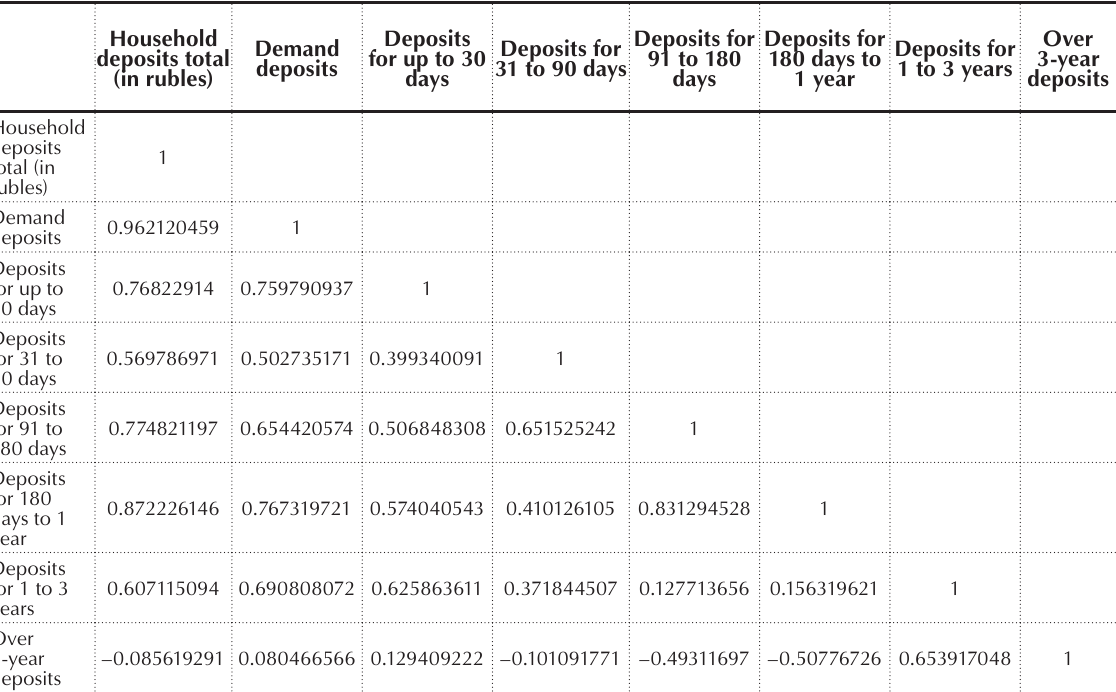
Table 9. (cid:18)(cid:381)(cid:396)(cid:396)(cid:286)(cid:367)(cid:258)(cid:415)(cid:381)(cid:374)(cid:3)